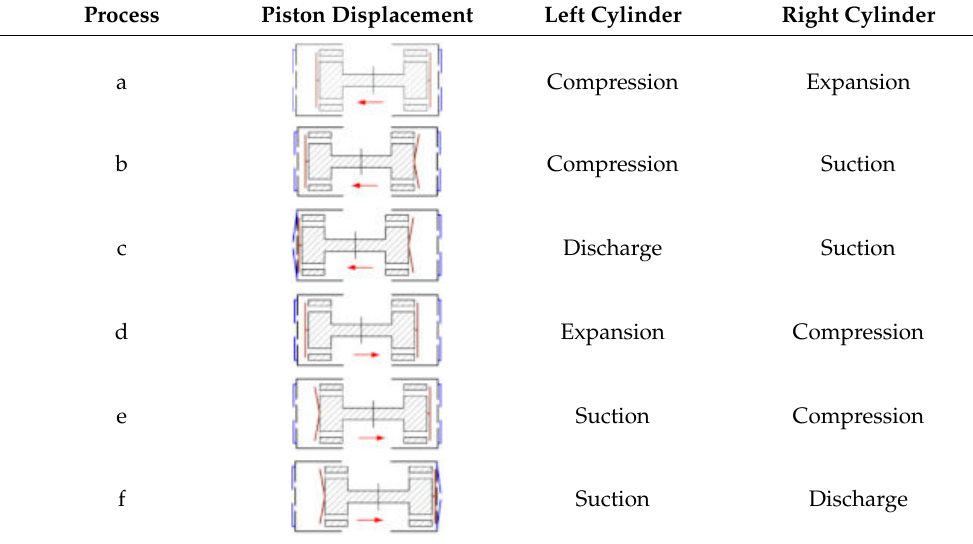
Table 1. Working processes of the